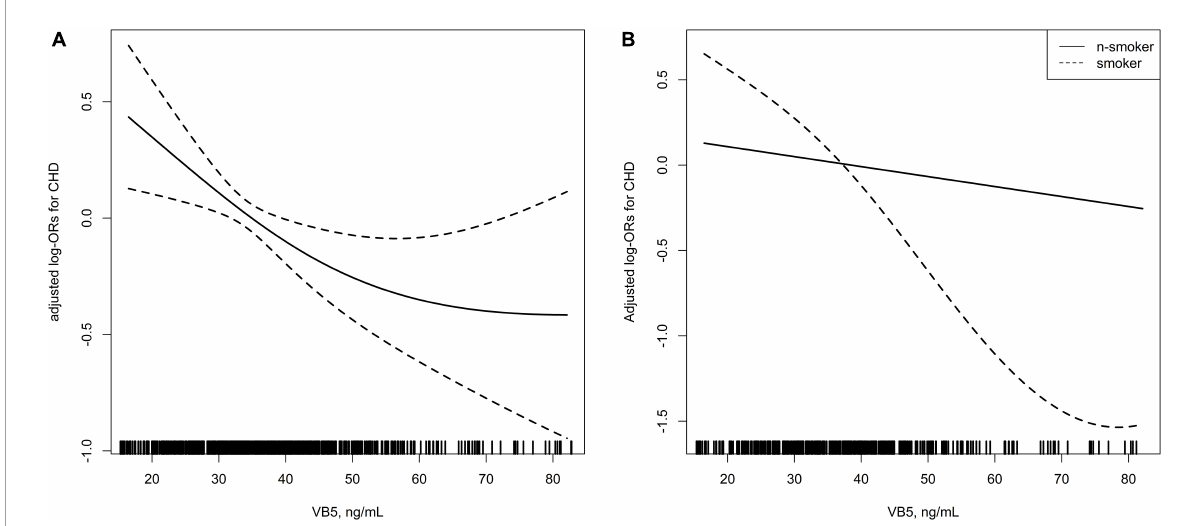
FIGURE2 (A) Smoothing curve showing the effects of plasma vitamin B5 on the risk of coronary heart disease (CHD). (B) Smoothing curve showing the effects of plasma vitamin B5 on the risk of CHD stratified by smoking